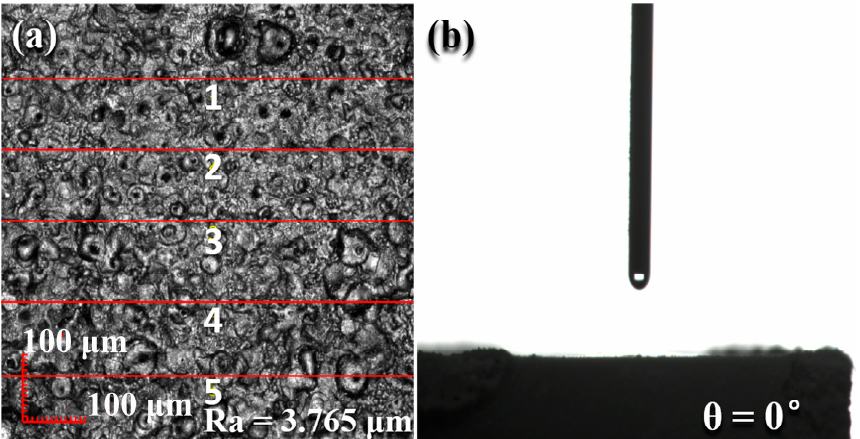
Figure 2. X-ray diffraction (XRD) pattern of the MAO coating.